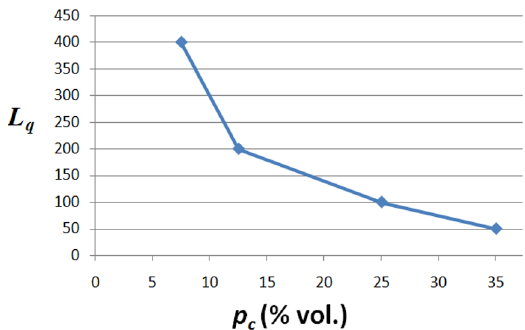
in function of p for 100 consecutive simulations for Figure 8. L q c the correction factor α = 10. However, reviewing the work of Hauptmanc et al. 35 for CB Printex XE 2 B, it was found that the average aggregate size was approximately 8 µ m in diameter, two times greater than the 400 simulated points. This would probably lead to a smaller p value. To evaluate this assumption, the linearization c of a curve of L as a function of p , Fig 8, was performed. q c This applied mathematical analysis on a logarithmic scale allowed adjusting a p 5% vol. value to a 8.6 µ m diameter, c near to the found in the literature 35 , for a linear regression coefficient, R , close to 99% as shown in Figure 9.